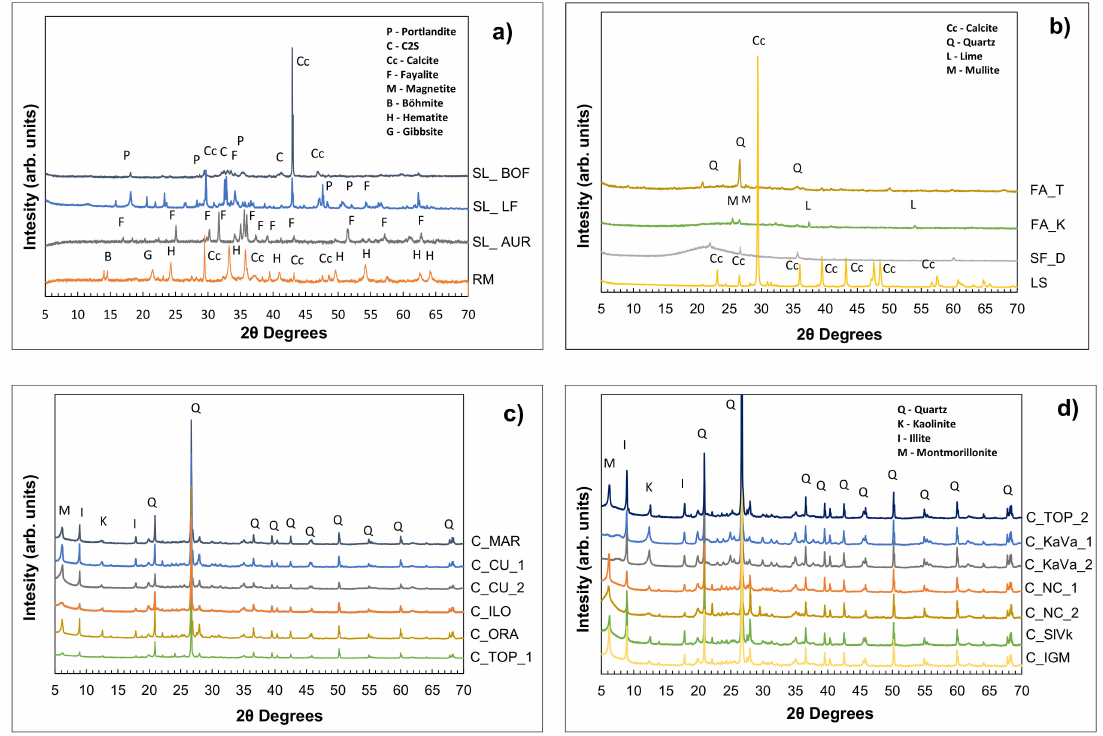
Figure 6. XRD pattern of raw materials: ( a ) slags, iron silicate fines and red mud ( b ) fly ashes, silica fume and limestone, ( c , d ) clays with indicated main identified